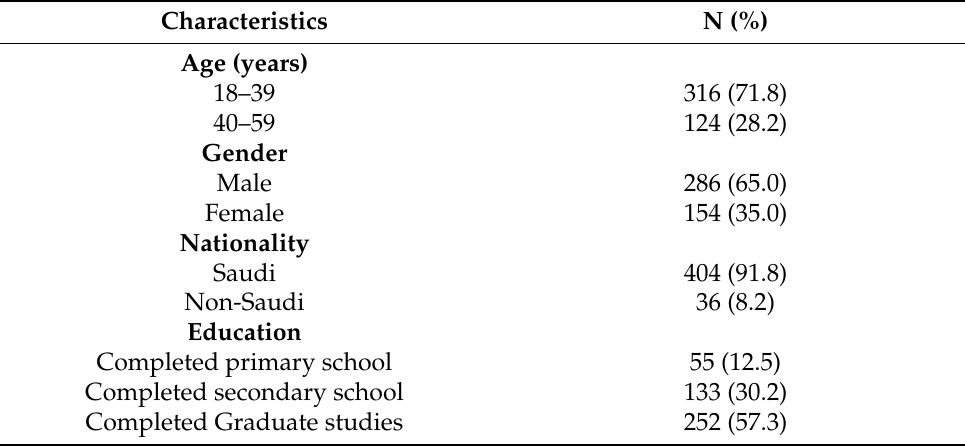
Table 1. Sociodemographic characteristics (n =